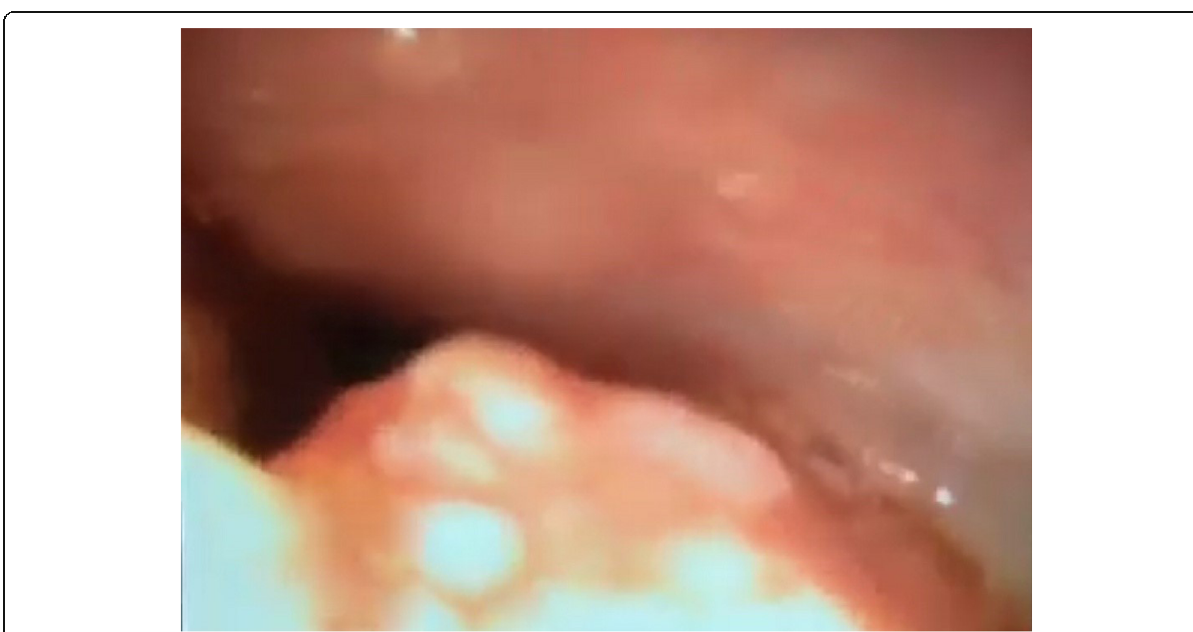
Fig. 5 Anterior laryngeal shift with distorted glottic aperture made fiberopticmanipulation through the glottis